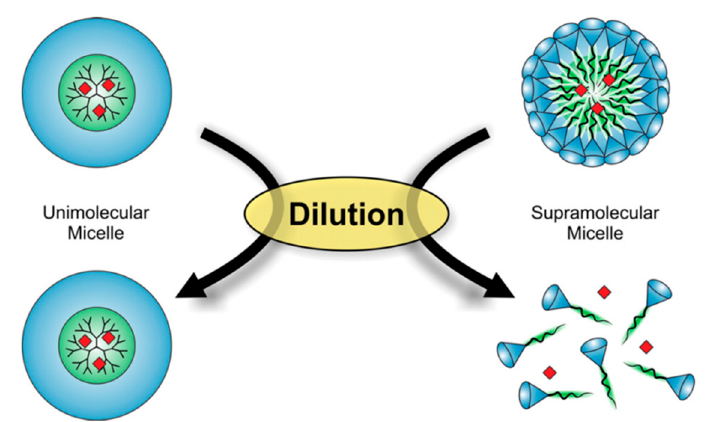
Figure 8. Covalently assembled unimolecular micelles such as symmetrical branch cell dendrimers and traditional multimolecular micelles derived from amphiphilic surfactants. Reprinted with permission from [51]. Copyright 2015 Elsevier.